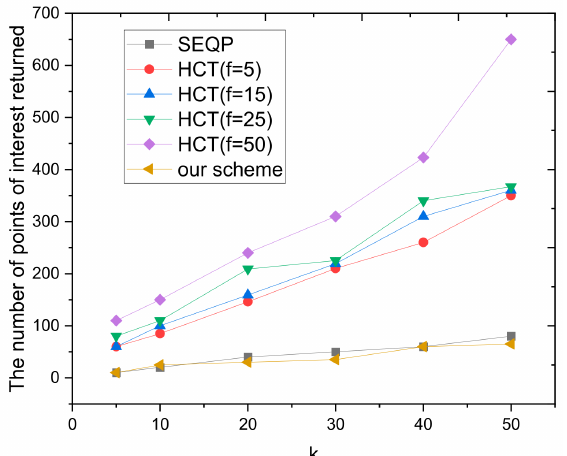
Figure 10. The number of points of interest returned under different requirements in the uniform